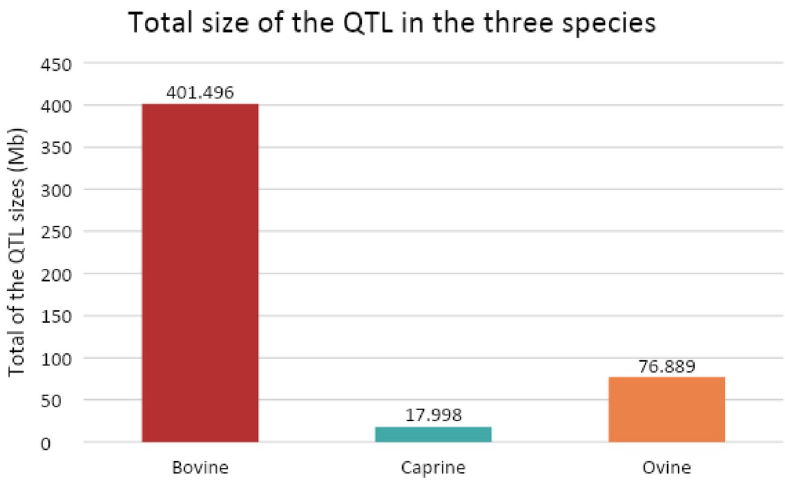
Figure 4. Total size of the whole QTL regions depending on the species, in megabases